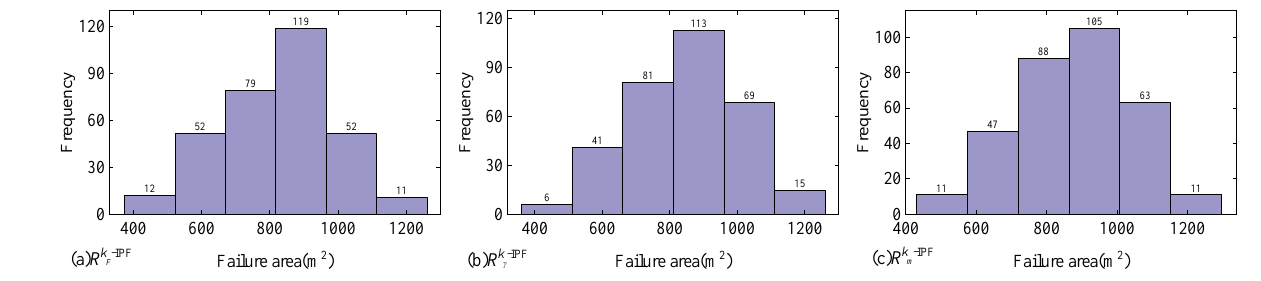
Figure 12. Heterogeneous Slope failure modes.